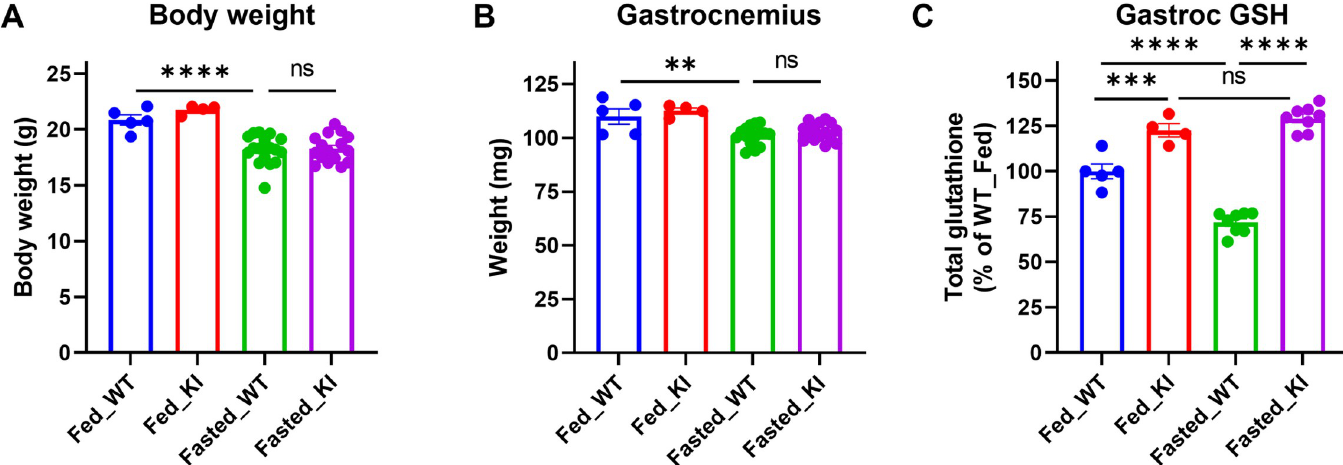
Fig 3. Chac1 inactivation preserves muscle glutathione but does not protect against fasting induced muscle atrophy. A. Body weight, and B. Gastrocnemius muscle weight measured after 24-h of fasting. C. Total glutathione measured in gastrocnemius muscle tissues. Results are shown as mean ± SEM with individual data plotted. Statistical significances were indicated as: ns not significant, * P < 0.05, ** P < 0.01, *** P < 0.001.